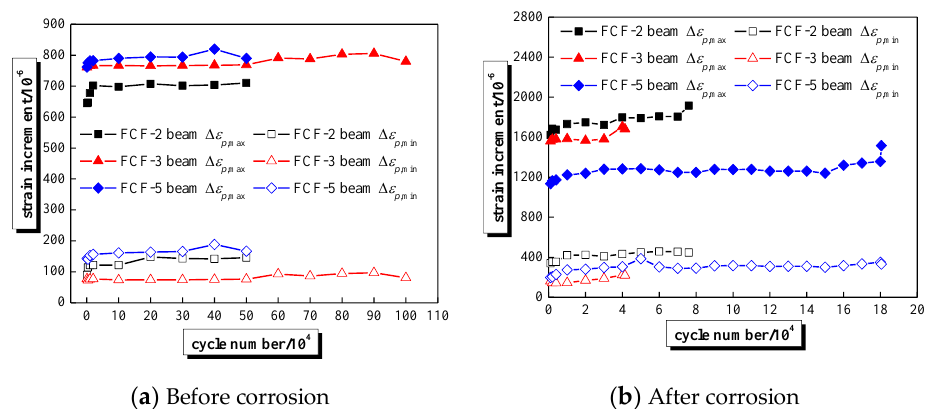
Figure 9. The maximum and minimum strain increment-load curves of steel strands.